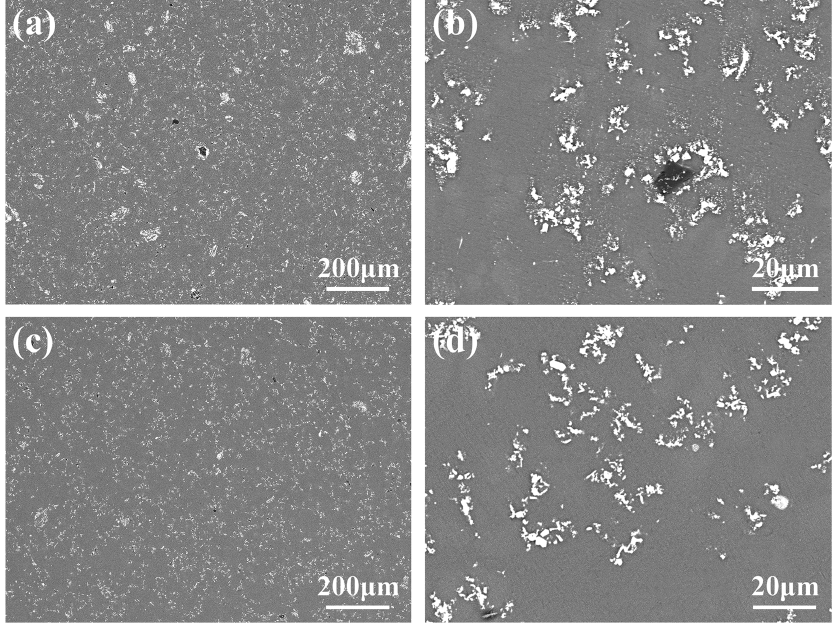
Figure 4. Microstructures of Al-4Ti-1C composites prepared by graphite with different sizes: ( a , b ) 30 μ m graphite and ( c , d ) 4 μ m graphite.